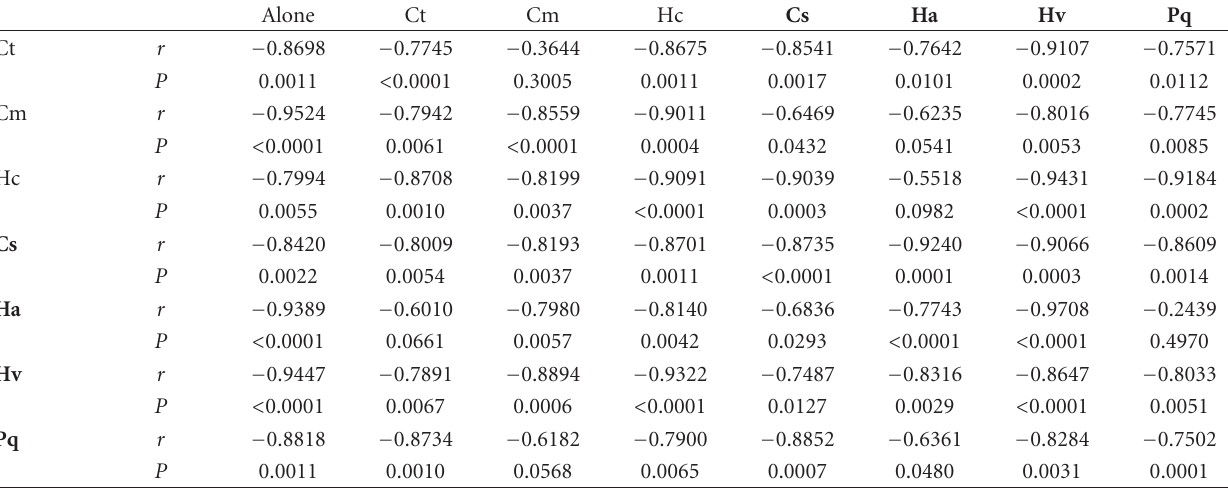
When beetles were paired with conspecifics, the data are listed separately for each beetle in the pair. Table 5: Correlations between aphid consumption and prey discovery time for single and paired lady beetles in trials ( N = 10). Each row represents the relationship between aphid consumption and prey discovery time for the species in the left column when it was alone or paired with the species in the first row of the table. Ct: Coccinella trifasciata , Cm: Coleomegilla maculata , Hc: Hippodamia convergens , Cs: Coccinella septempunctata , Ha: Harmonia axyridis , Hv: Hippodamia variegata , Pq: Propylea quatuordecimpunctata . Nonnative species are printed in bold